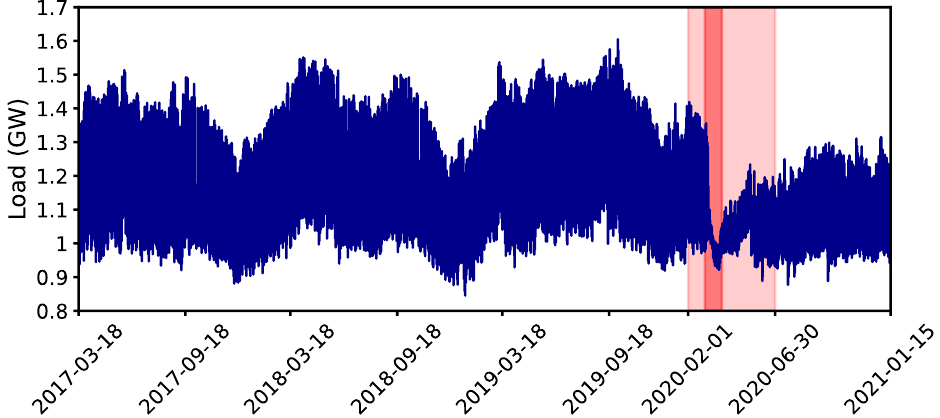
Figure 1. Electricity demand curve of “IEEE DataPort Competition Day-Ahead Electricity Demand Forecasting: Post-COVID Paradigm”. The light red region corresponds to the lockdown period. The dark red area corresponds to the most significant impact on demand during this period.